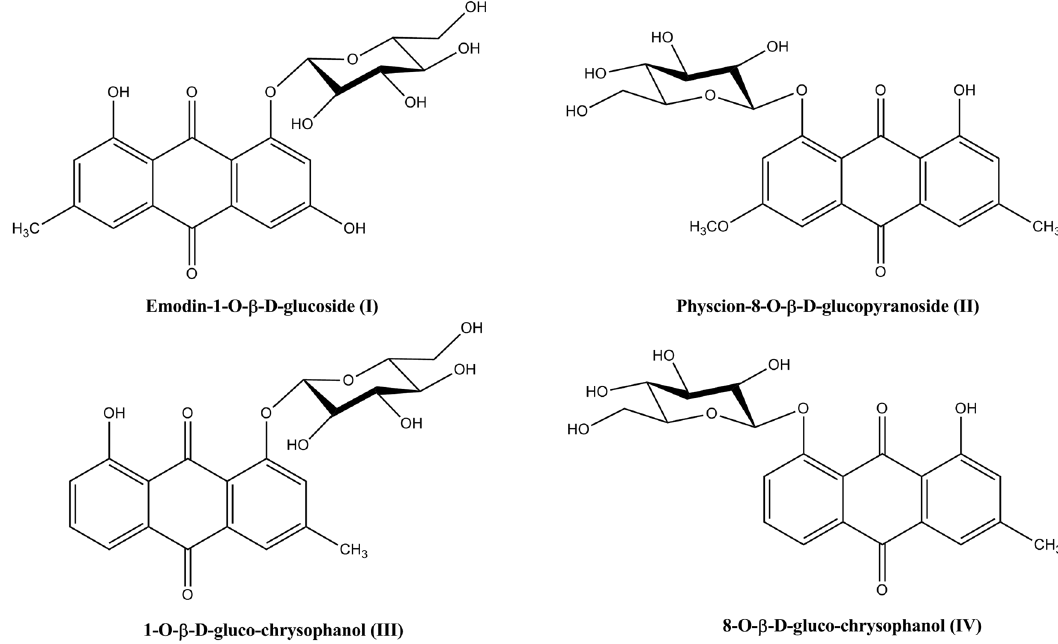
Figure 4: Molecular structures of the four anthraquinone